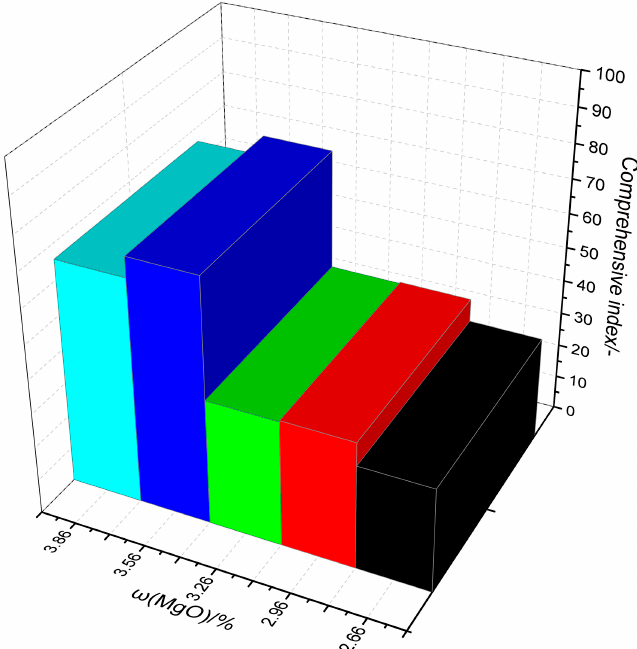
Figure 13. Comprehensive evaluation index of the CCVTM sinter with various MgO concentrations.